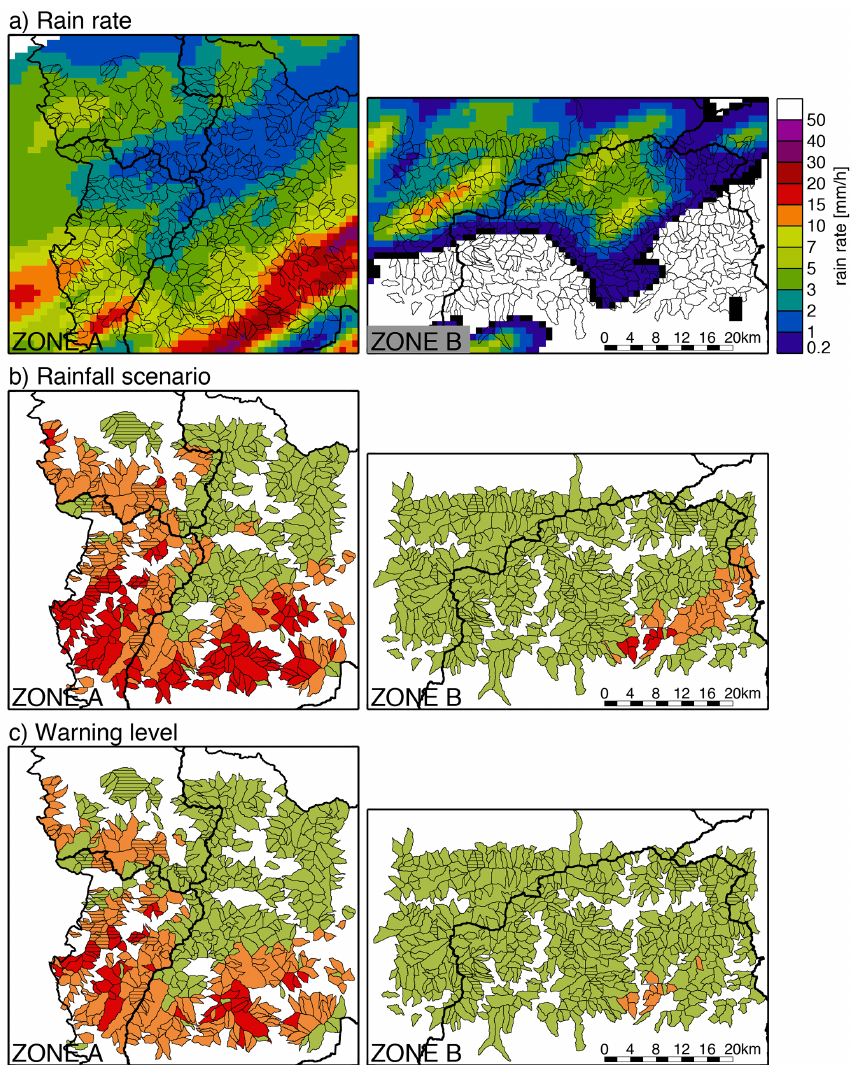
Figure 9. Example of the implementation of the developed technique over the analysis domain on 23 July 2010 at 01:30UTC: (a) 30min rainfall intensity estimated from radar observations; (b) magnitude of the rainfall situation estimated in each subbasin (green, orange and red correspond to the classes “weak”, “moderate” and “severe” rainfall); (c) warning level obtained in each subbasin (green, orange and red correspond to the warning level classes “low”, “medium” and